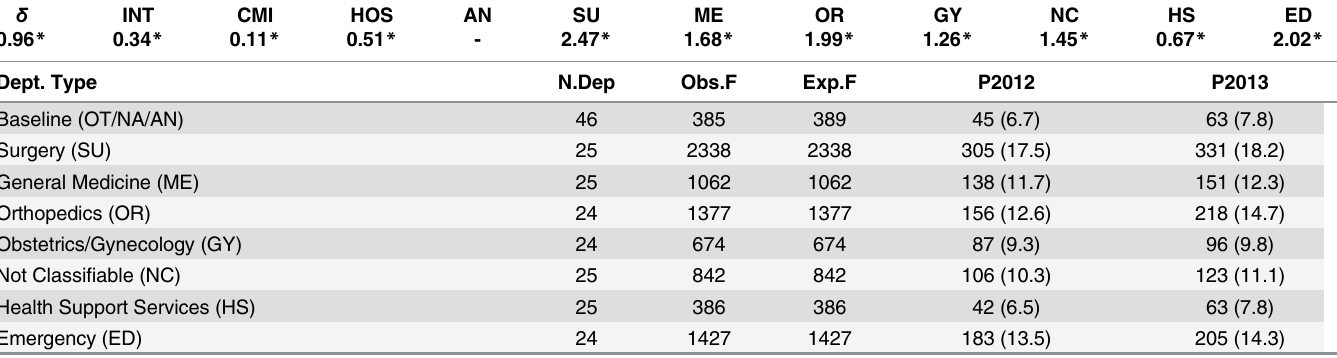
Table 6. Results for injuries, for the Lombardia region. Estimates of the parameters of the Poisson model as per Appendix 2.1, number of departments of a given type that generated each alleged type of claim (N.Dep), observed frequencies of claims for the different types of departments (Obs.F), expected fre- quencies according to the model (Exp.F), and predicted claims for 2012 (P2012) and 2013 (P2013), together with their standard deviations (in brackets).